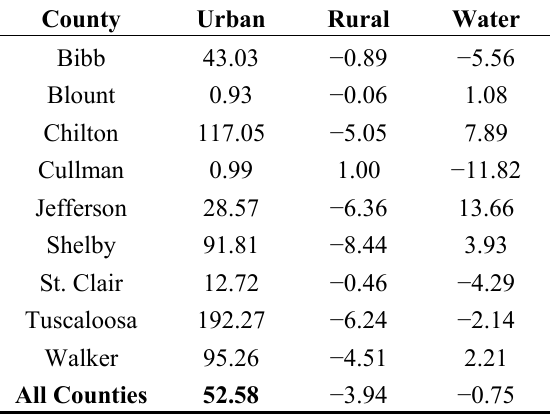
Table 2. Percent change of land use categories from 1998 to 2010 based on county. County Urban